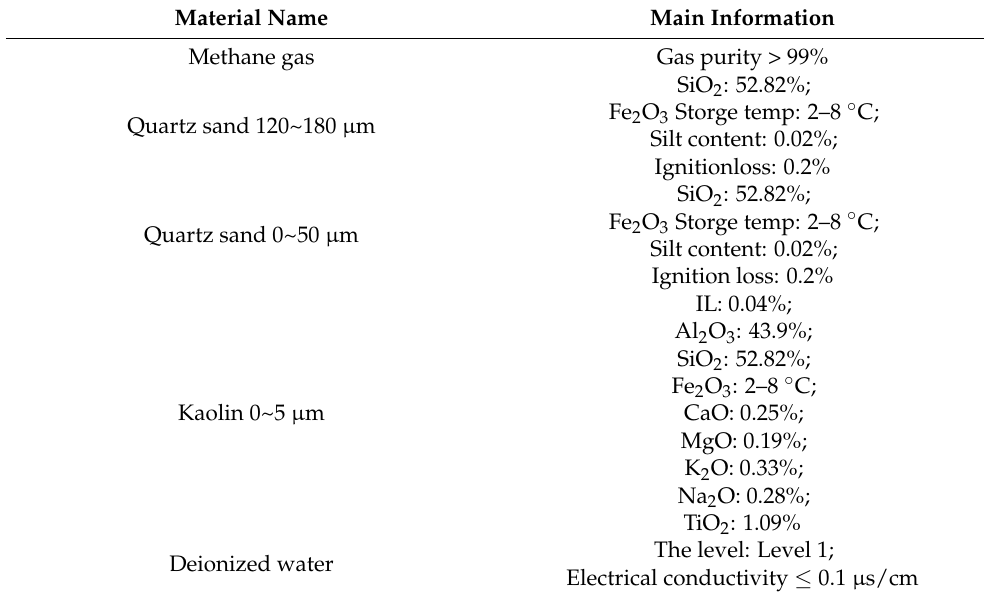
Table 3. Basic information sheet of experimental materials.